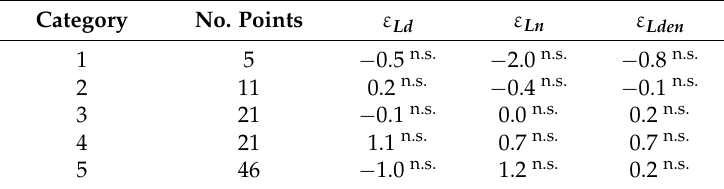
Table 5. Prediction errors ( ε ) of the categorisation method for L d , L n and L den